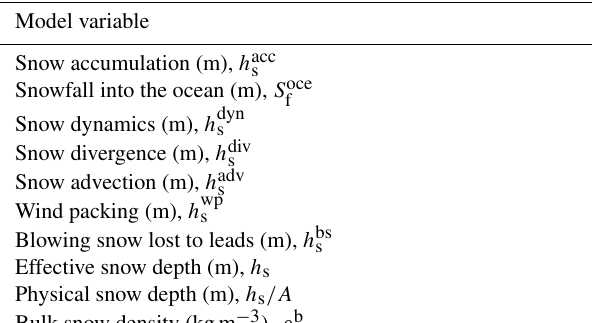
Table 1. Default model forcings and parameter settings used by NE-